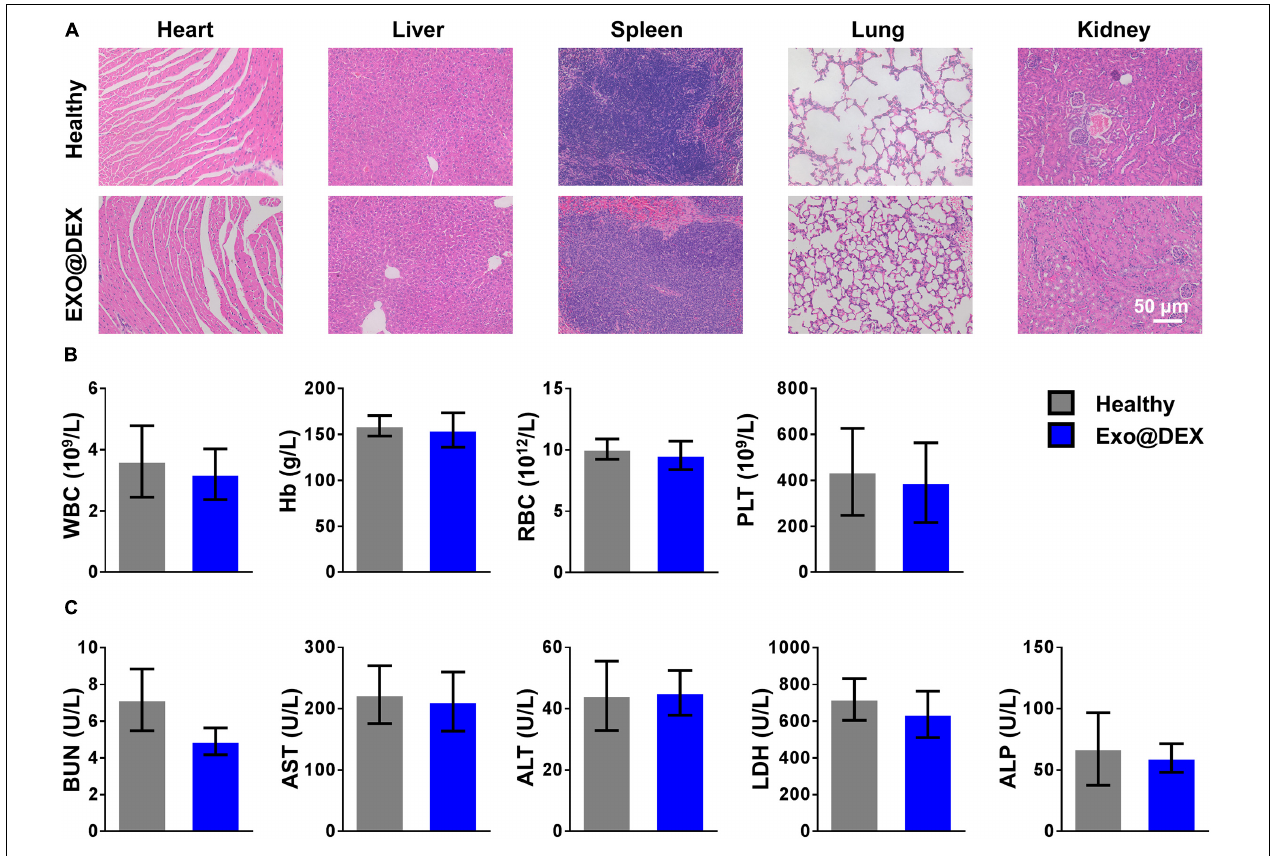
FIGURE 6 | In vivo toxicity assessment of Exo@DEX. (A) H&E staining of major organs (heart, liver, spleen, lungs, and kidneys). (B) Routine blood test of whole-blood parameters in mice treated with PBS or Exo@DEX. (C) Serum levels of liver and kidney function parameters in mice treated with PBS or